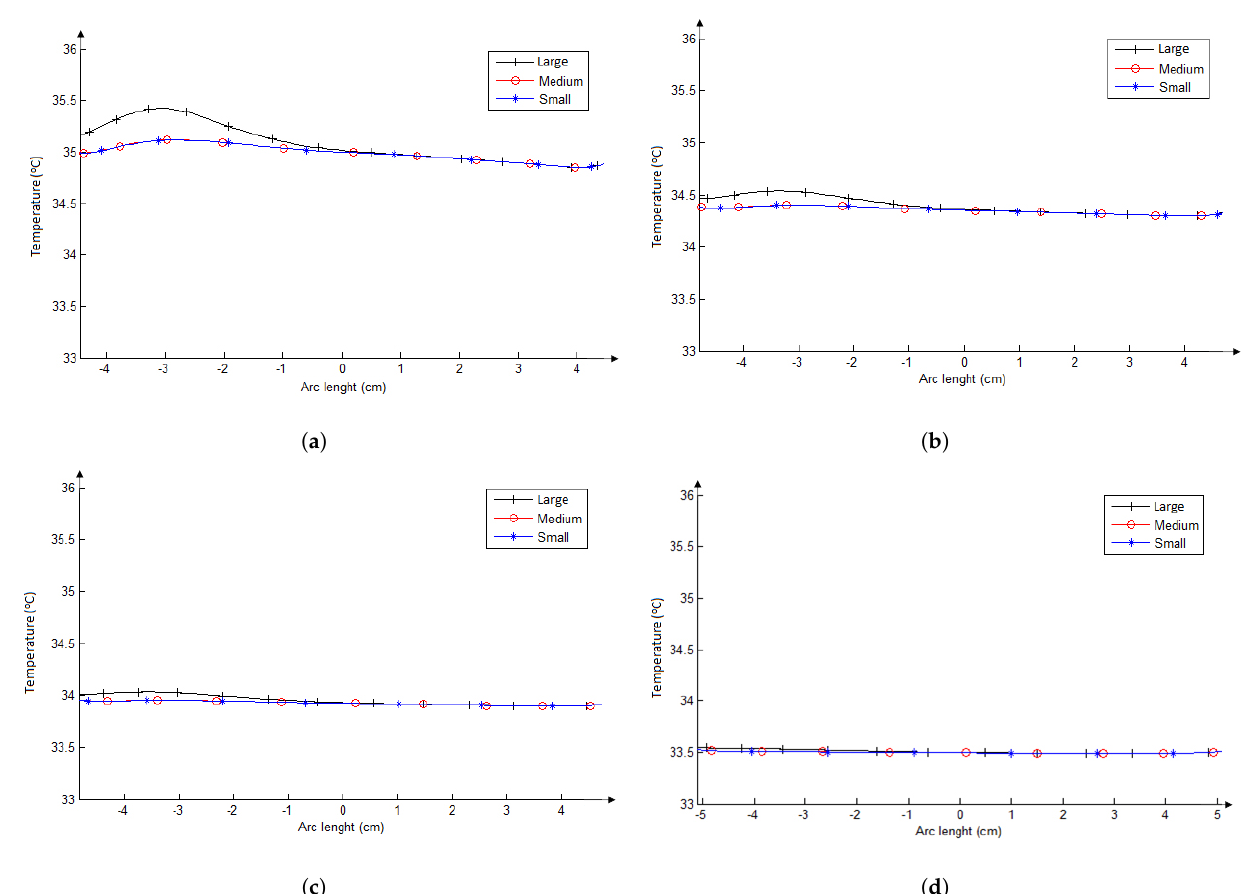
Figure 8. Superficial temperatures for the large (black line), medium (red line), and small (blue line) nodules of necks with fat tissue layer thickness from 0 cm ( a ), 0.3 cm ( b ), 0.6 cm ( c ), to 1.2 cm ( d